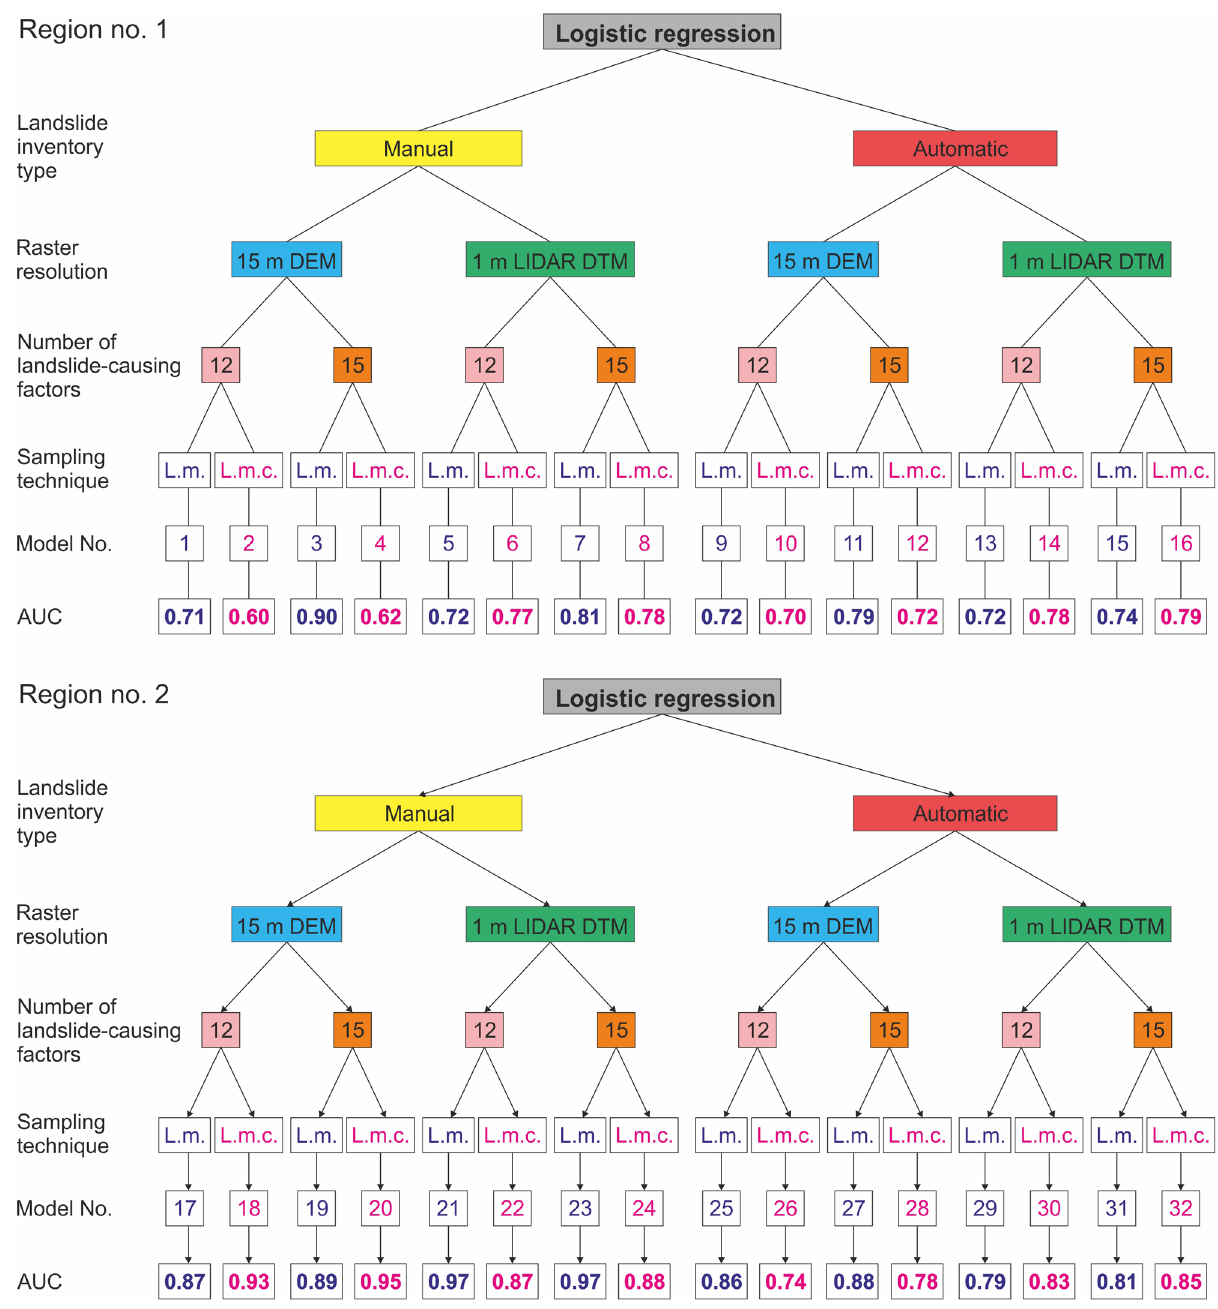
Figure 6. Comparison of the AUC (area under the curve) values for the resulting landslide susceptibility models based on different input data (see Table S2); landslide sampling technique: l.m.—landslide mass, l.m.c.— landslide mass center. Figure was designed and created in CorelDRAW 2018 (https:// www. corel draw. com/